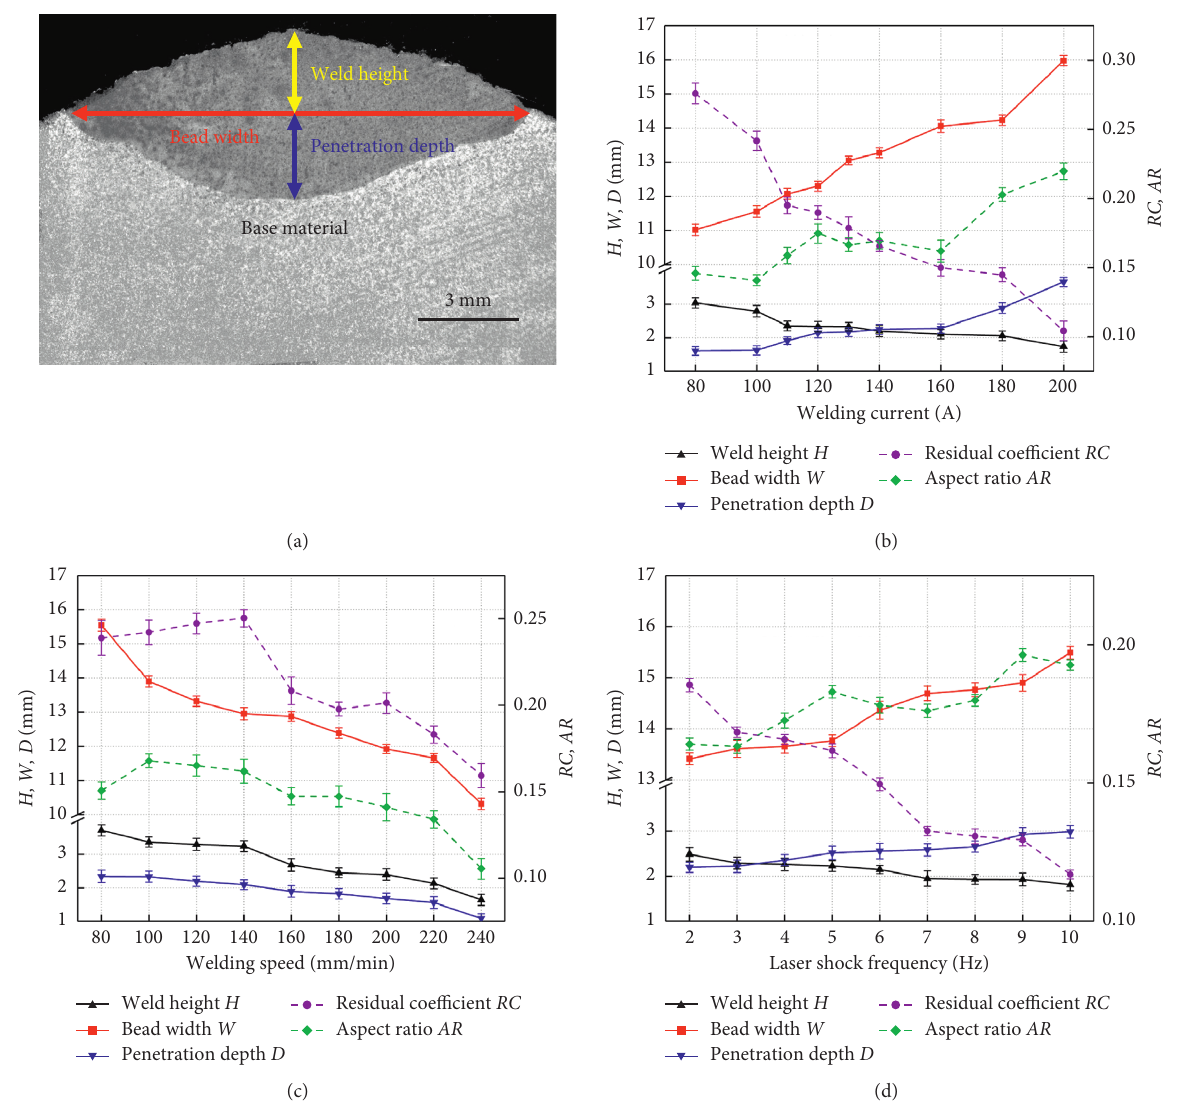
Figure 4: (a) Optical macrograph of the Q235 steel pipe welded via AW-LSF (welding current of 110A, welding speed of 140mm/min, and laser shock frequency of 2Hz), which illustrates the geometric characteristics. (b–d) Effects of the AW-LSF parameters on the weld height ( H ), bead width ( W ), penetration depth ( D ), aspect ratio (AR), and residual coefficient (RC). (b) Welding current. (c) Welding speed. (d) Laser shock